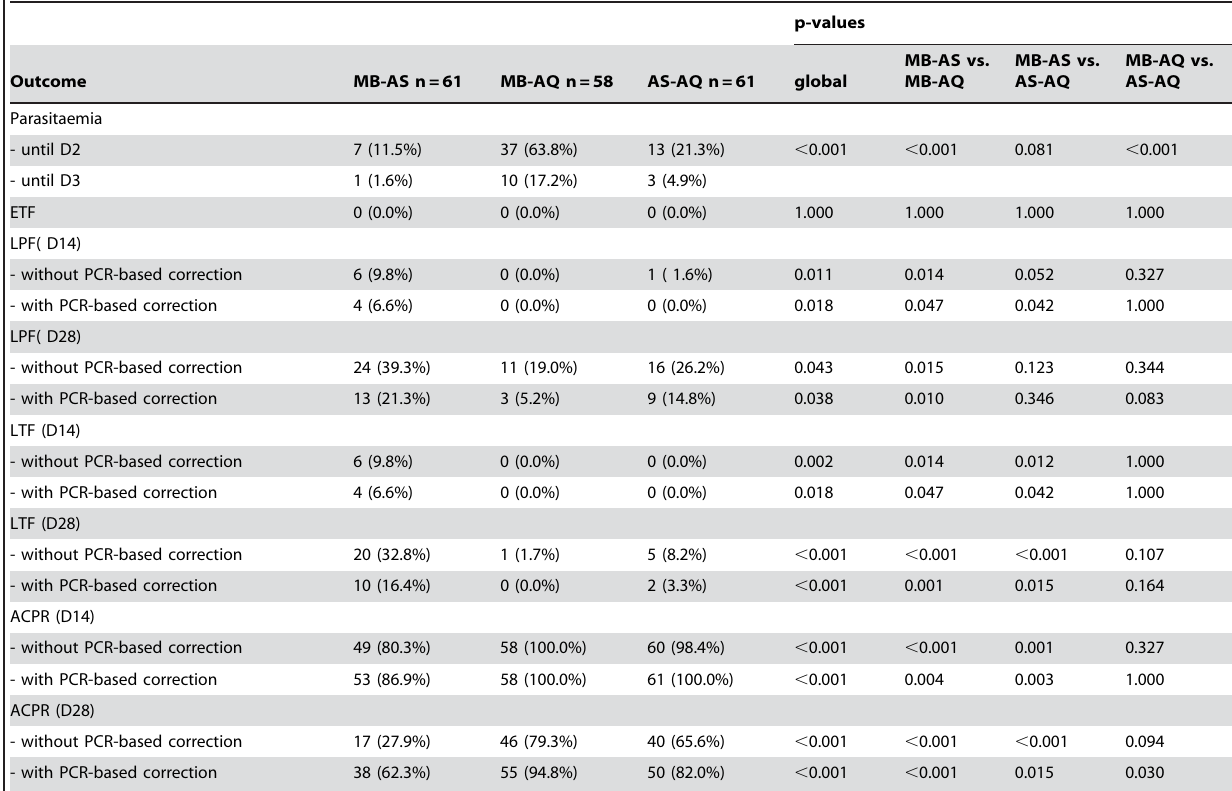
Table 3. Efficacy outcomes in the three study groups